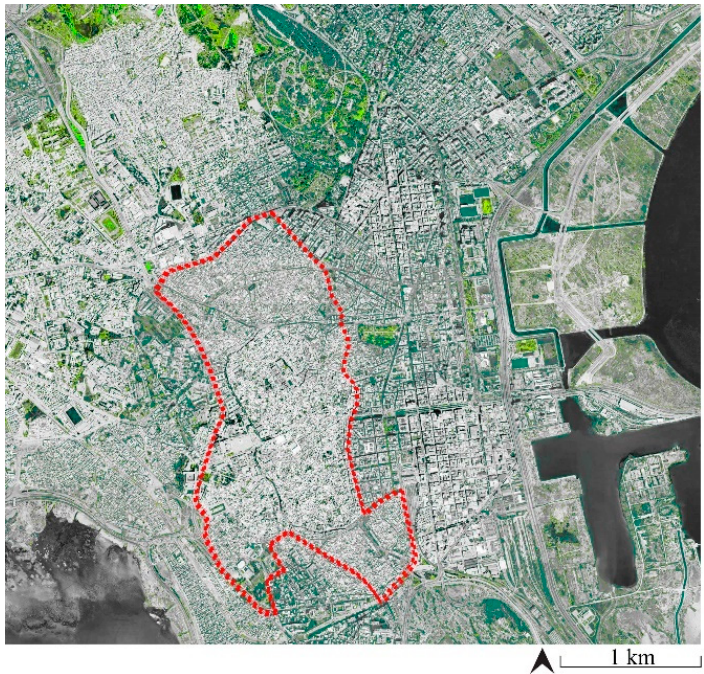
Figure 10. The UNESCO heritage site delimitation of Marrakesh Medina and the green spaces in the territory (data source: